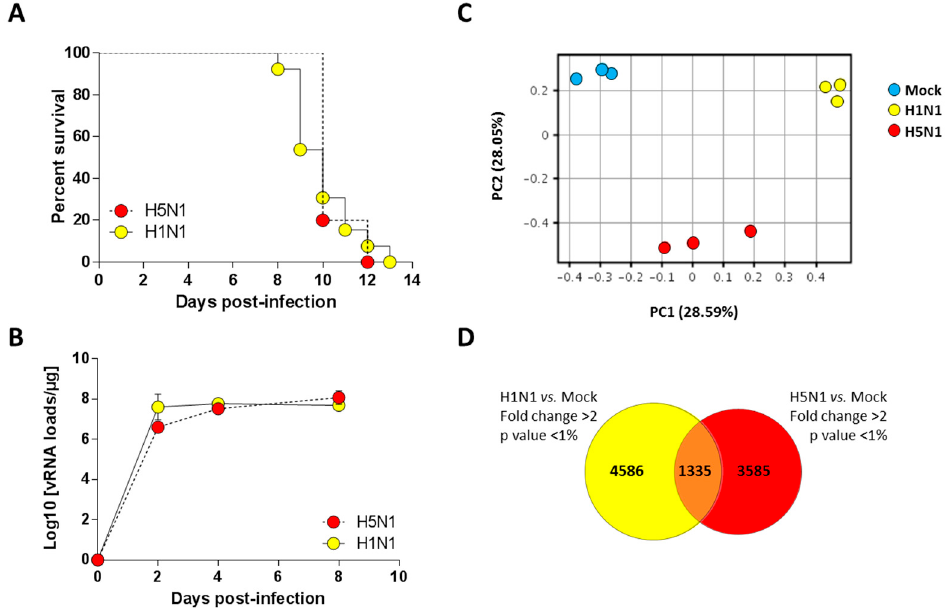
Figure 1. Survival curves and viral loads of infected mice. ( A ) Lethalities of H5N1 and H1N1 were compared in mice infected with 1.4 × 10 2 PFU and 1.5 × 10 5 PFU of H5N1 ( n = 10) or H1N1 ( n = 13), respectively. ( B ) Viral load in the lungs of H5- and H1-infected mice were measured using quantitative RT-PCR and expressed as copy numbers per µg of total lung RNA. Results are the mean ± SD obtained from six mice. ( C ) Principal component analysis of the lung genes normalized expression values. X-axis represents the first dimension (Component 1, 28.59% of the variance) which separates the mock conditions from the infected conditions, the y-axis represents the second dimension (Component 2, 28.05% of the variance) which separates the viral infections (i.e., H1N1 vs. H5N1). ( D ) Venn diagram depicting the differentially expressed genes ( ≥ 2.0-fold change, p -value < 0.05) common or unique to H1N1- and H5N1-infected mice relative to mock-infected mice.